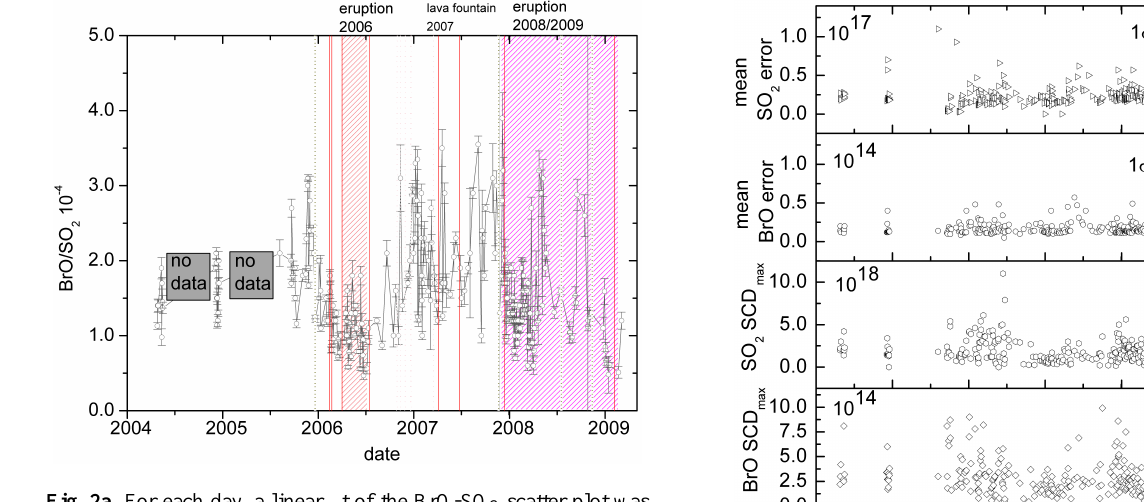
Fig. 2a. For each day, a linear fit of the BrO-SO 2 scatter plot was obtained. The slope of this linear fit with its standard deviation in form of an error bar is plotted as function of time. Note that the slope and its standard deviation were obtained by including the one sigma-fit error of the BrO evaluation in the fitting process of the linear slope. The SO 2 fit error was neglected as it was small (two orders of magnitude smaller) compared to the SO 2 measure- ment values. The potential large error due to radiative transfer issues (Kern et al., 2010) was neither for SO2 nor BrO taken into account in this study. Besides the data 2006–2009, data of 2004 and 2005 were added. Before both eruptions (2006 and 2008), an increase in the BrO/SO 2 ratio can be noted, followed by a general decrease in bromine monoxide in comparison to sulphur dioxide during periods of explosive and effusive volcanic activity. In 2006, the BrO/SO 2 ratio decreased until the end of the year and basically until the end of the enhanced activity of Etna. Also with the end of the 2008/2009 eruption, the BrO/SO 2 ratio stopped its decreasing trend. The erup- tion periods are indicated by an underlying rectangle of magenta, and higher activity events are shown by red lines. The year on the x-axis indicates the middle of the same year. For more detailed in- formation, see text.